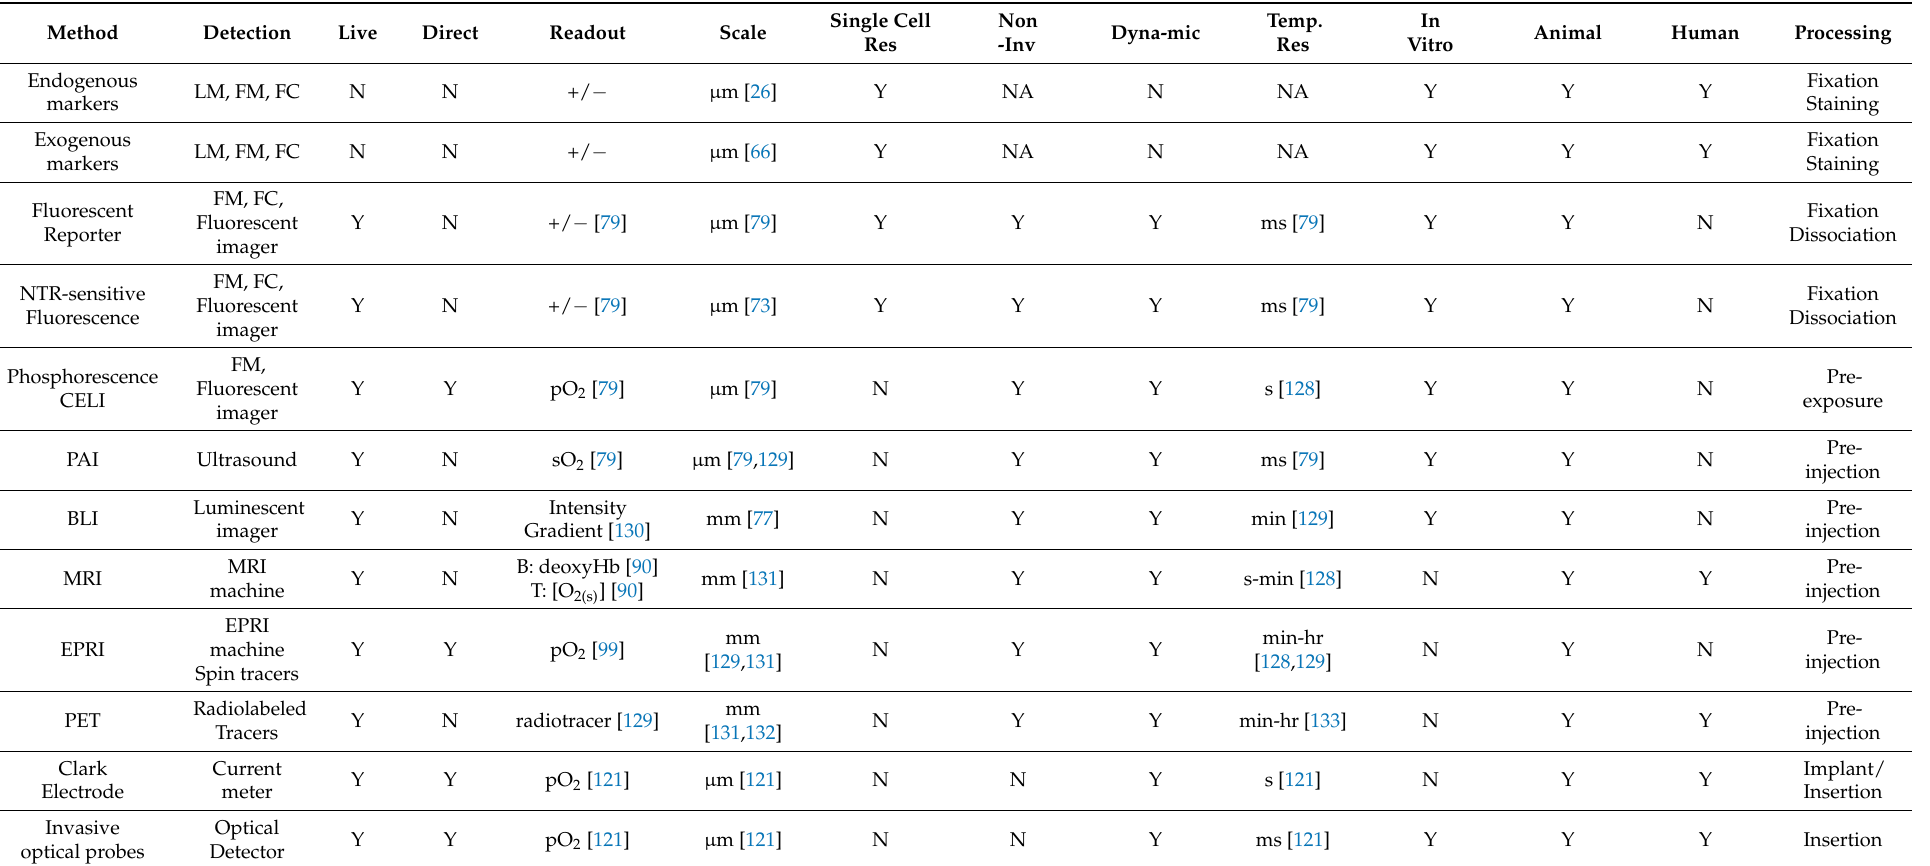
Table 1. Compilation of methods to detect hypoxia. Partially adapted from [79,128]. Y = Yes; N = No; NA = Not Applicable; +/ − = positive-negative